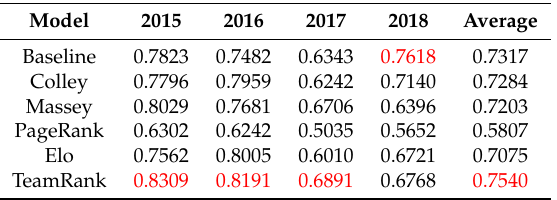
Table 3. Kendall rank correlation of the results. Red values indicate the highest Kendall rank correlation for each season.